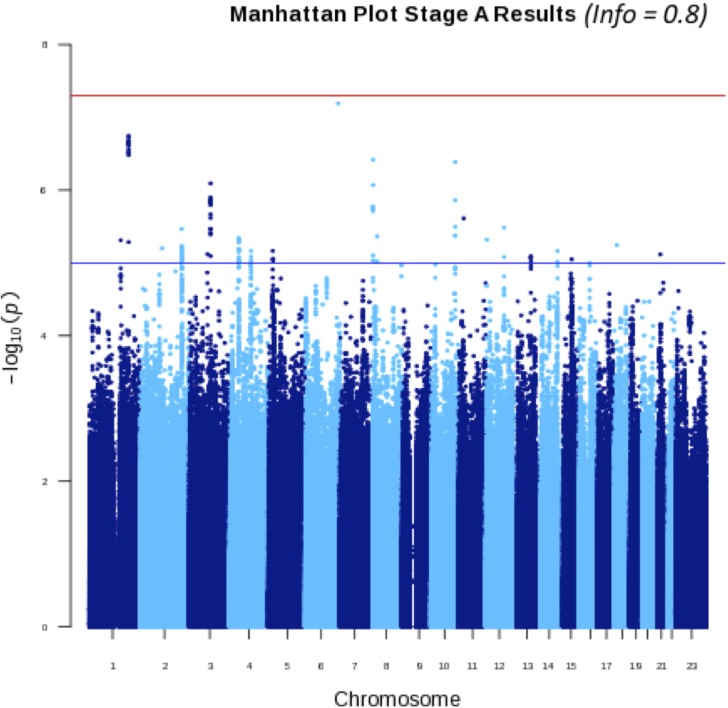
Manhattan plot of association of single-nucleotide polymorphisms (SNPs) with Stage A endometriosis in the GWAS. Red horizontal line marks the genome-wide significance (P < 5 × 10−8), and blue line marks nominal significance (P < 5 × 10−6).